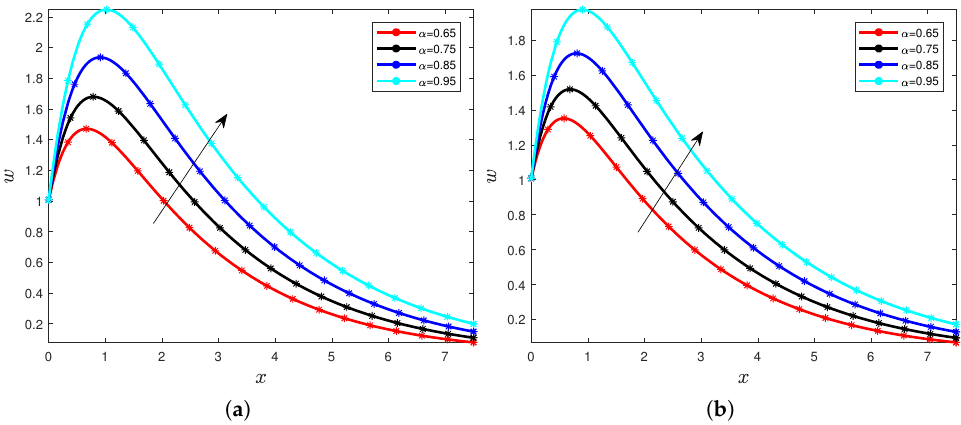
Figure 2. Velocity for different values of the order α with Pr = 15 ( a ) and Pr = 20 ( b ).